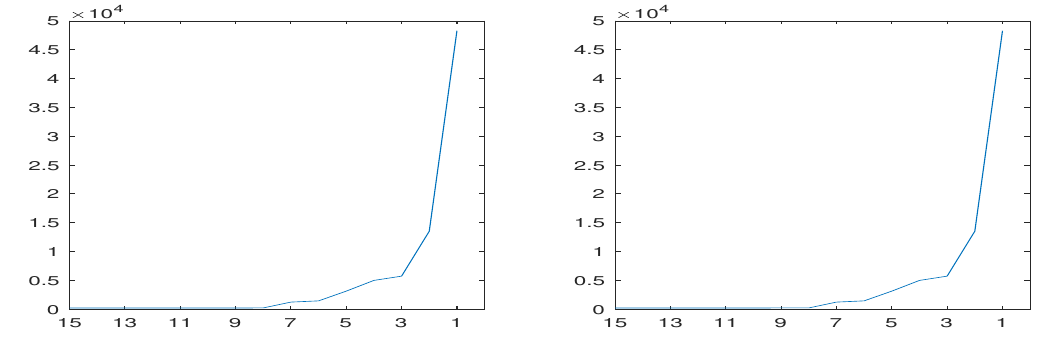
Figure 4: Left side: mean values of the largest 15 singular values of A n ; right side: one typical outcome for the largest 15 singu- lar values of A n in Example 5.4.